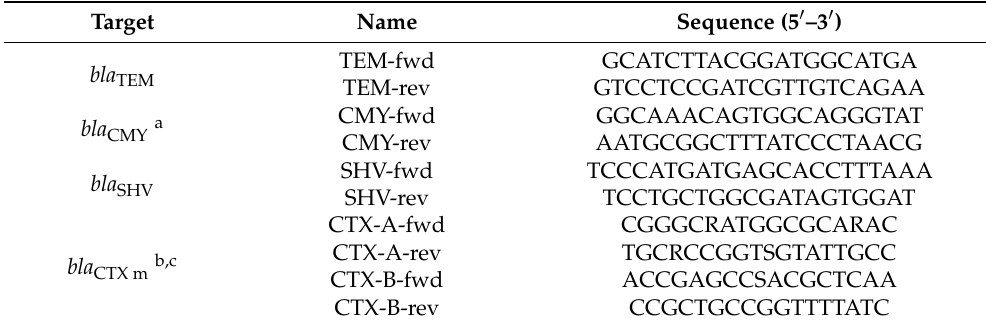
Table 3. Primers used in this study